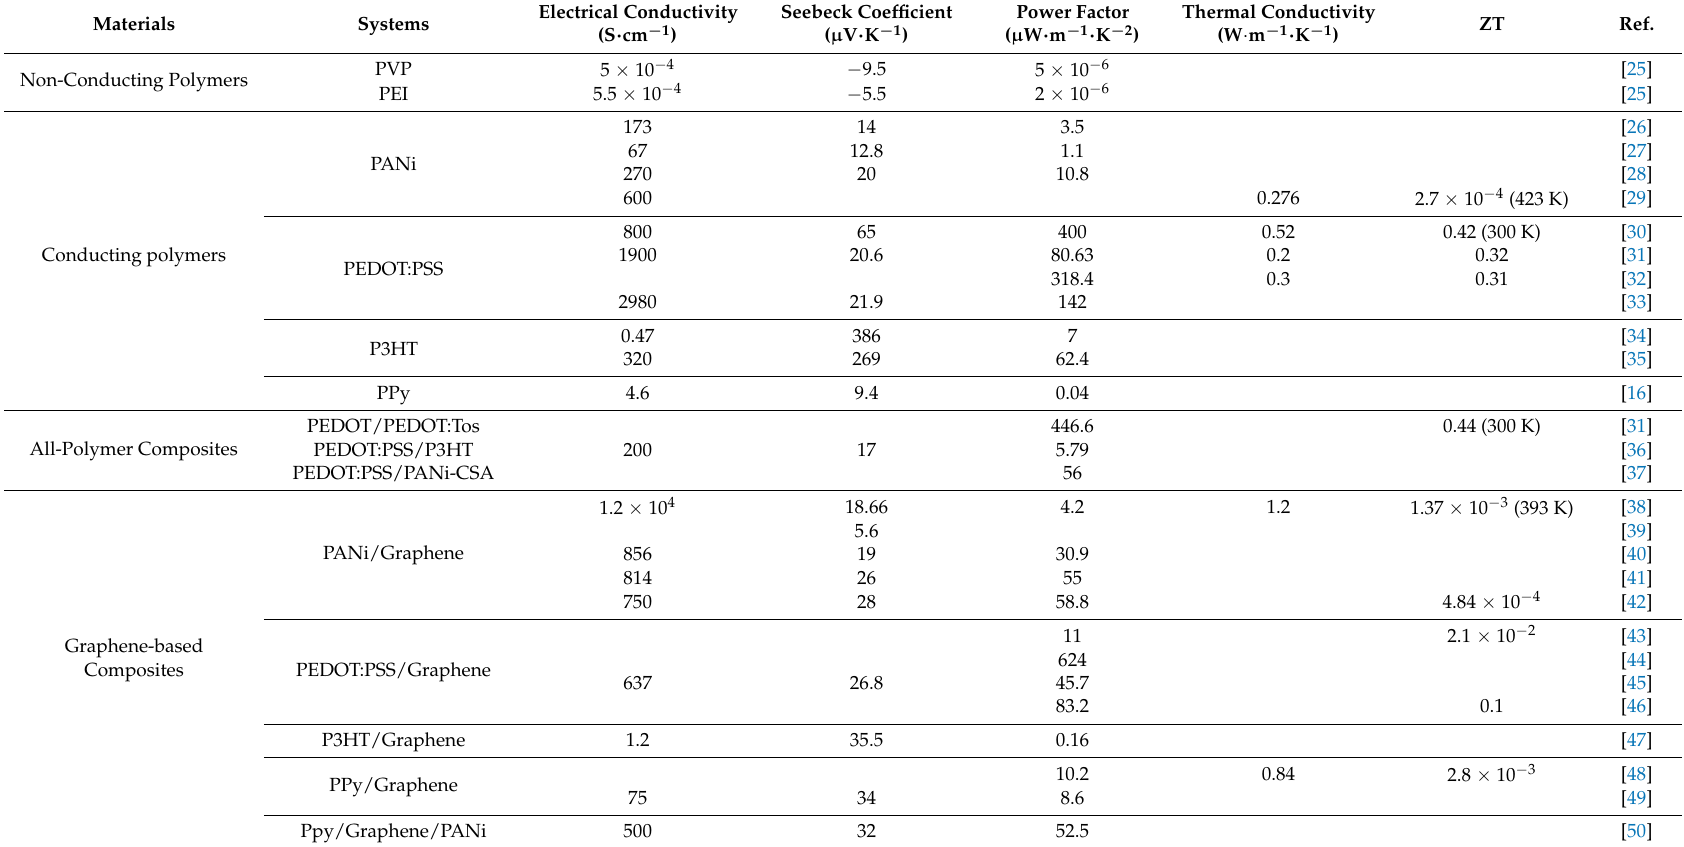
Table 2. The thermoelectric properties of polymers and carbon nanofiller-filled polymer